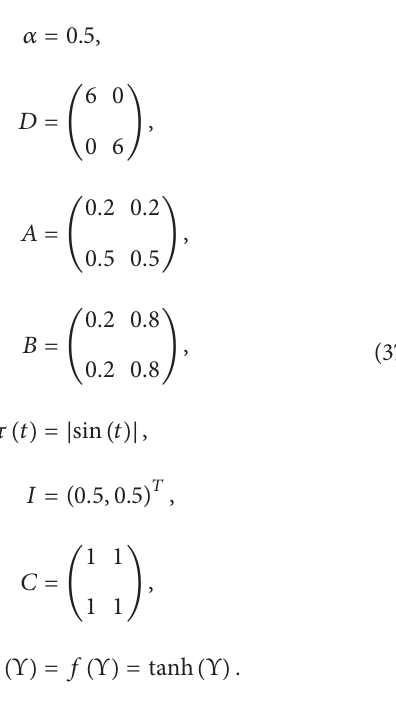
Figure 1: Chaotic behavior. Example 1. Consider a two-dimensional neural network model (5) described by